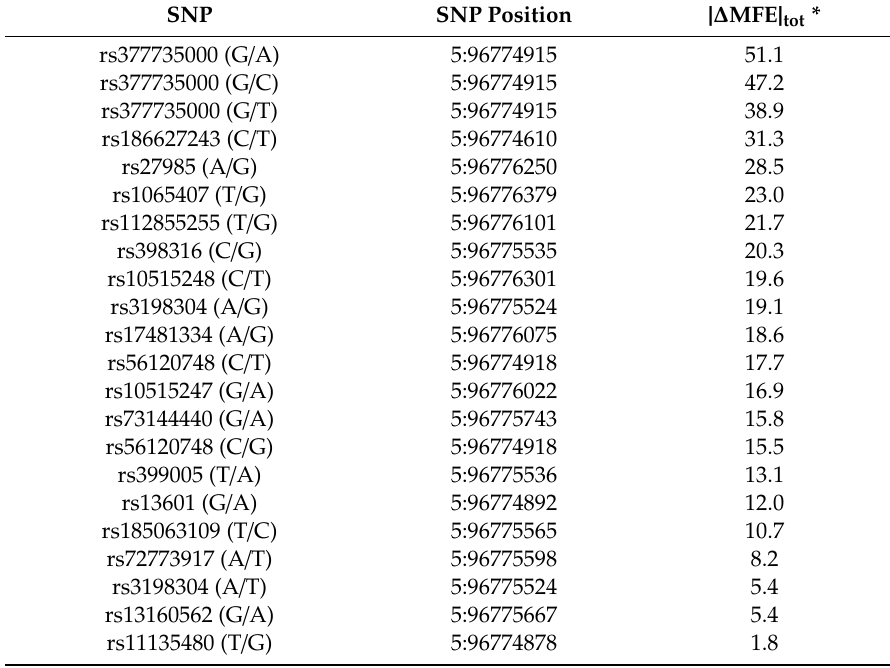
Table 3. Sum of the absolute values of variation of MFE ( ∆ MFE) for each identified SNP in descending order. SNP SNP